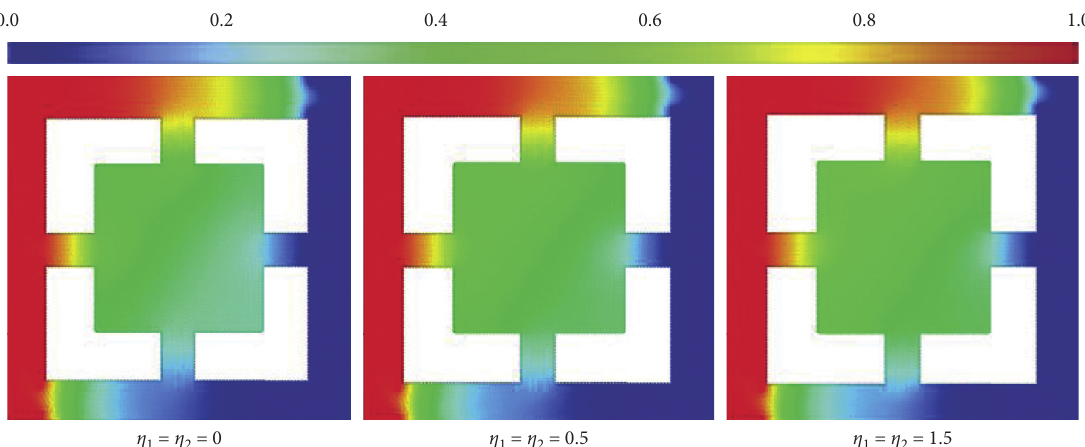
Figure 12: Features of temperature below the variations of a porous level, η Le � 20, and τ �